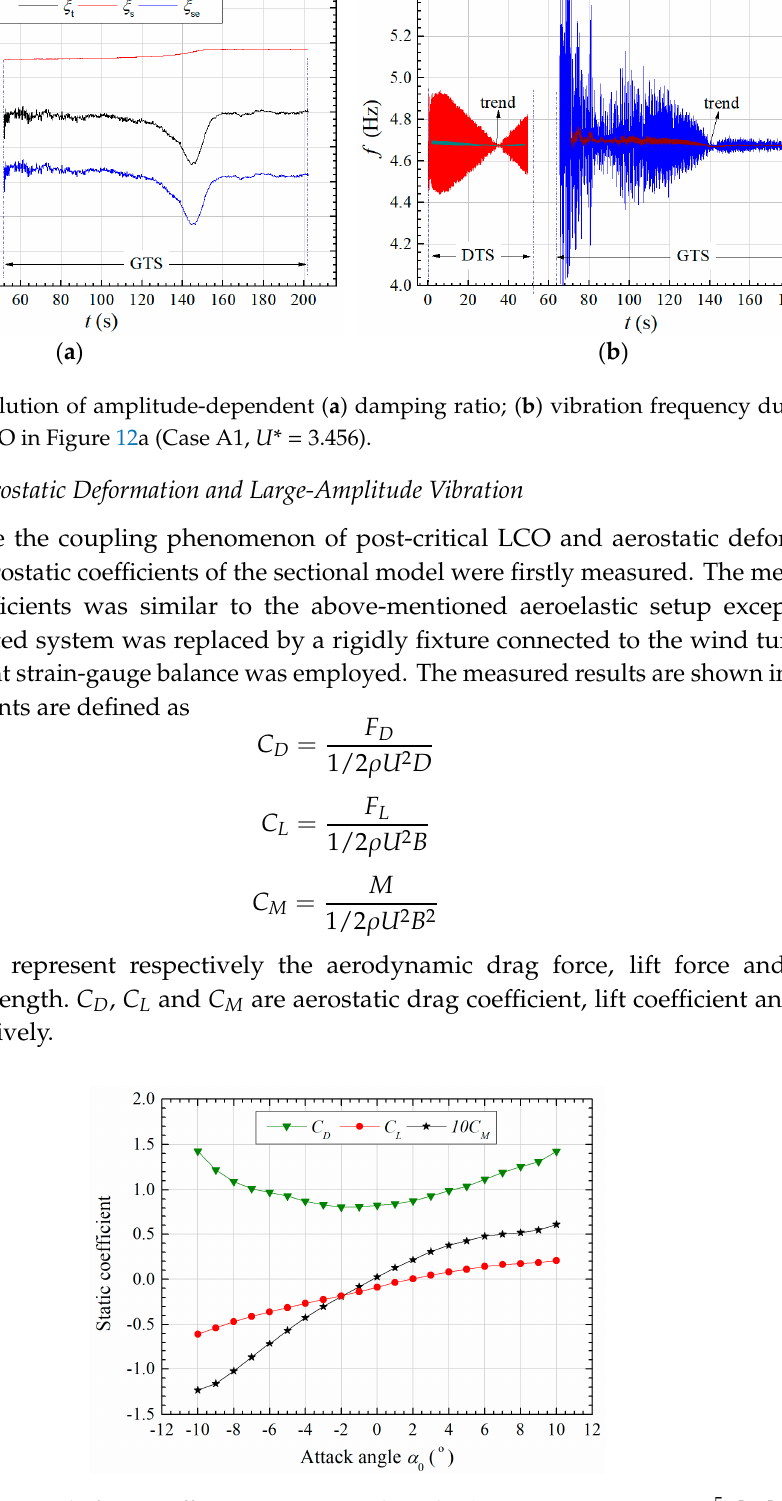
Figure 14. Steady force coefficients versus attack angles ( Re = ρ UB / μ = 4.656 × 10 5 )